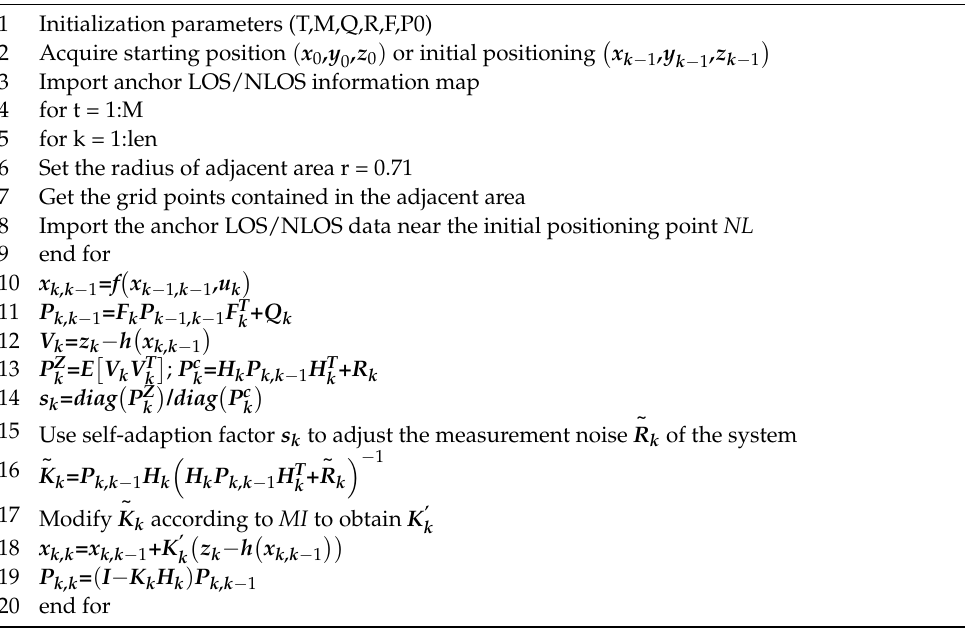
Algorithm 1. Adaptive EKF Algorithm Code Based on Anc LOS/NLOS Information